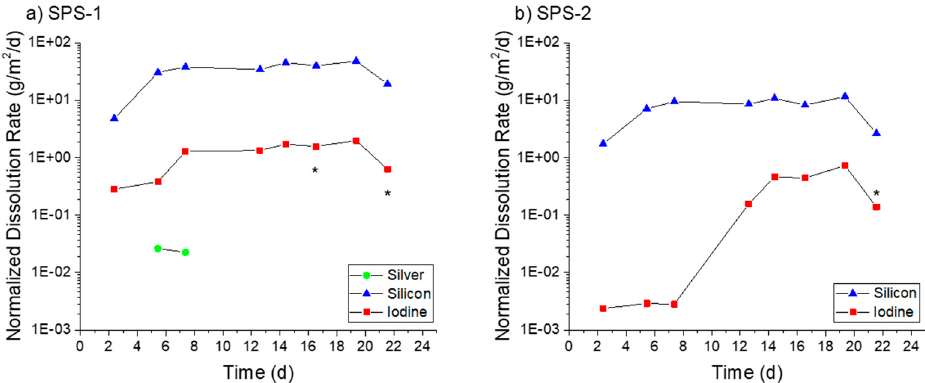
Figure 14. Normalized dissolution rates calculated from SPFT experiments using the SFA samples at pH 11 for: ( a ) SPS-1; and ( b ) SPS-2 (+20 wt % SFA). The asterisks (*) mark samplings where the flow rate deviated by >10% from the average flow of the test.